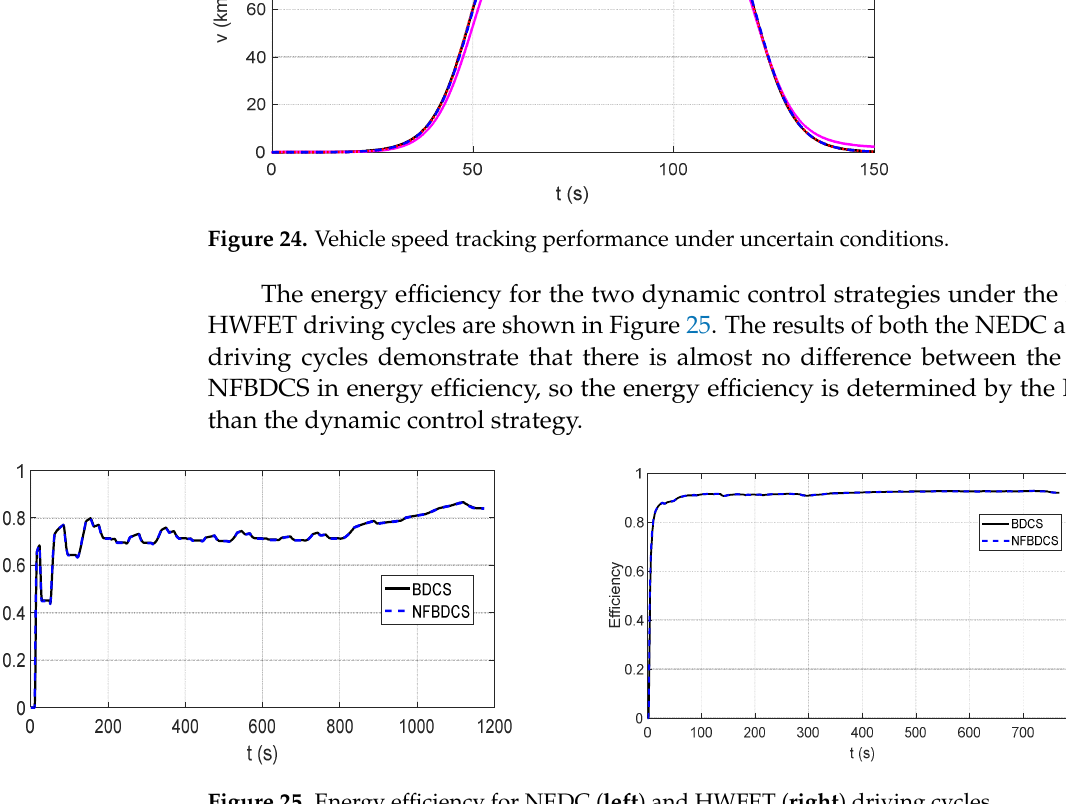
( b ) Figure 23. ( a ) Jerk of vehicle with Δ t = 0.1 s, ( b ) Jerk of vehicle with Δ t = 0.1 s (amplified). The driving torque of the BDCS is absolutely based on the backward-facing dynamic model, so the accuracy of the parameters in the model determines its vehicle speed track- ing performance. When all the parameters in the dynamic model are accurate, the BDCS can track the ideal vehicle speed. However, there are many unavoidable uncertain param- eters in the system, e.g., the vehicle mass changes with the number of passengers. Consid- ering the actual vehicle mass is larger than its normal value with 10% amplitude, the ve- hicle’s actual speed under the three control strategies is shown in Figure 24. It can be found that the BDCS cannot track the ideal vehicle speed, while the CFBDCS and NFBDCS have good tracking accuracy, because the CFBDCS and NFBDCS contain the PI controller